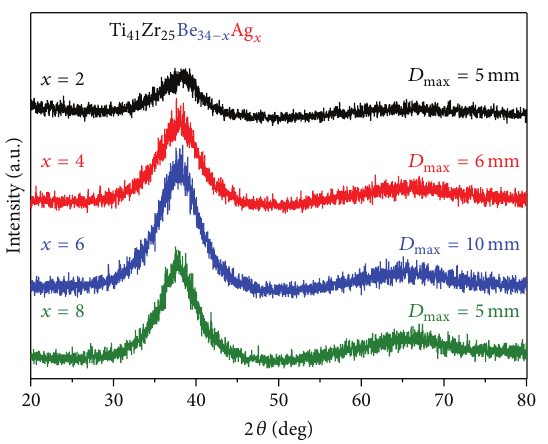
Ag ( x = 2, 4, 6, 8 at.%) x x